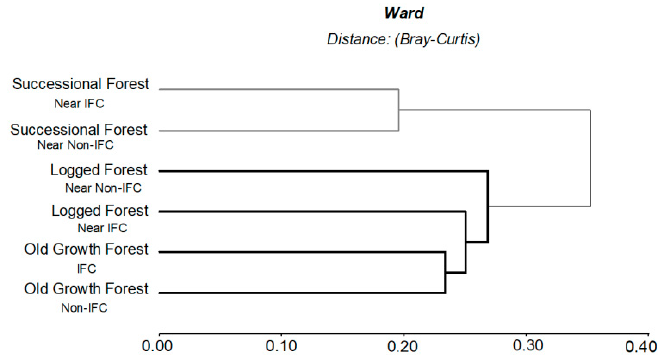
Figure 5. Similarity analysis based on species important index value (IVI) for di ff erent forest types in IFC landscapes and non-IFC landscapes.